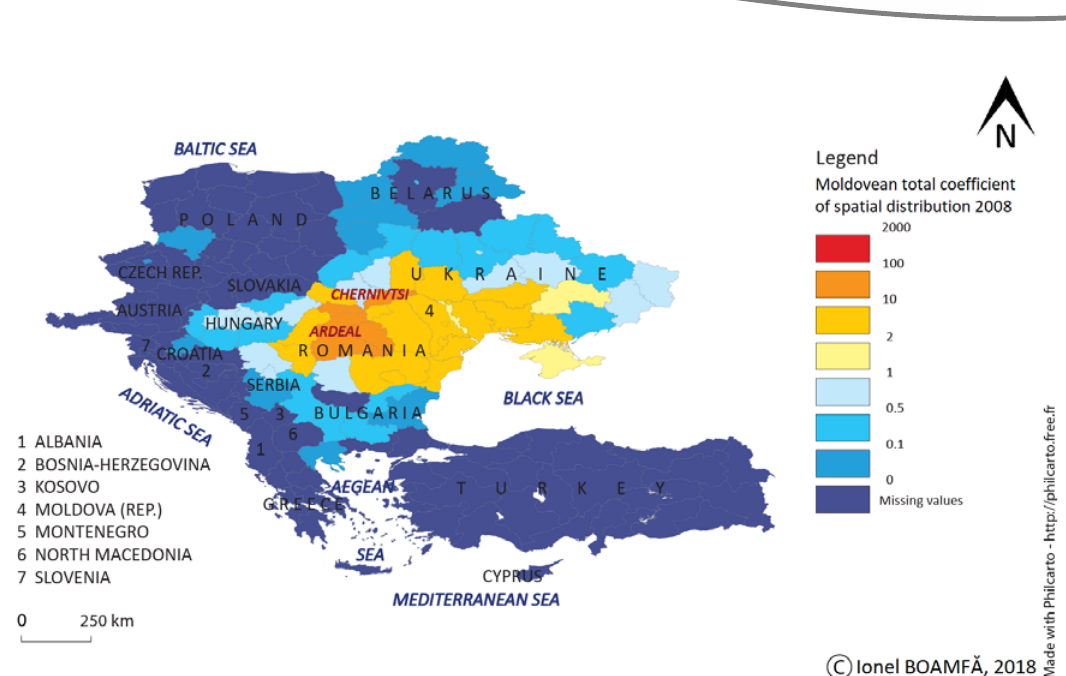
Figur e 1 . G eographical repartition of the anthroponym Moldovean. Coef. of spatial distribution